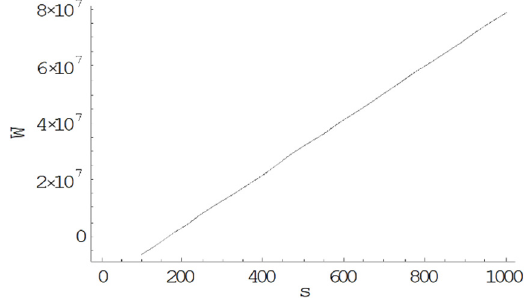
Figure 13. Total cost versus parameter s .